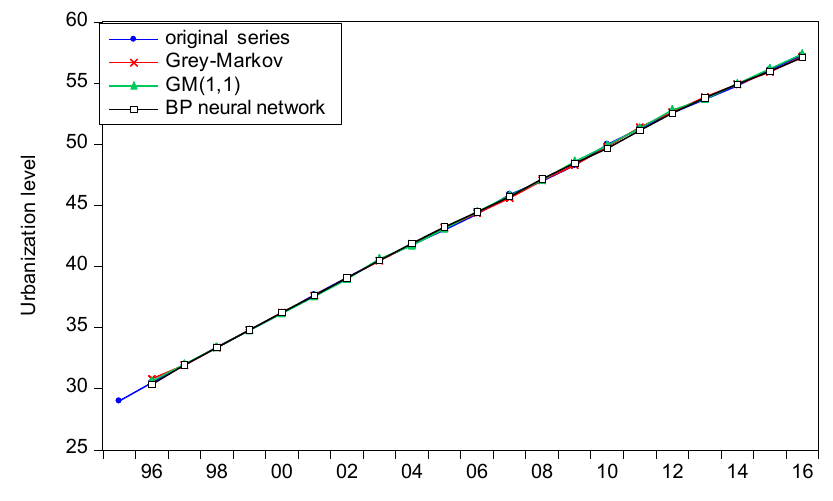
Figure 7. The forecasting results for line loss rate.